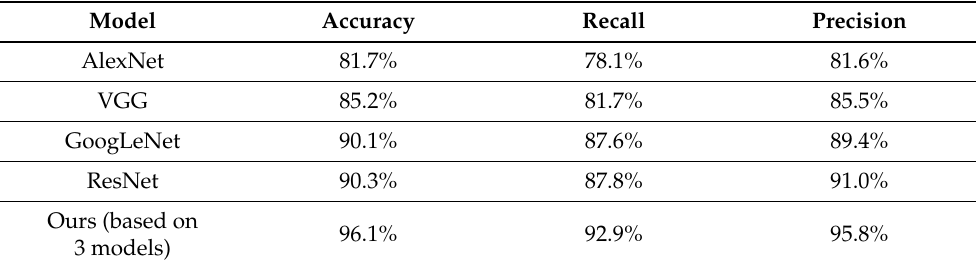
Table 5. Comparison of single CNN and our method.